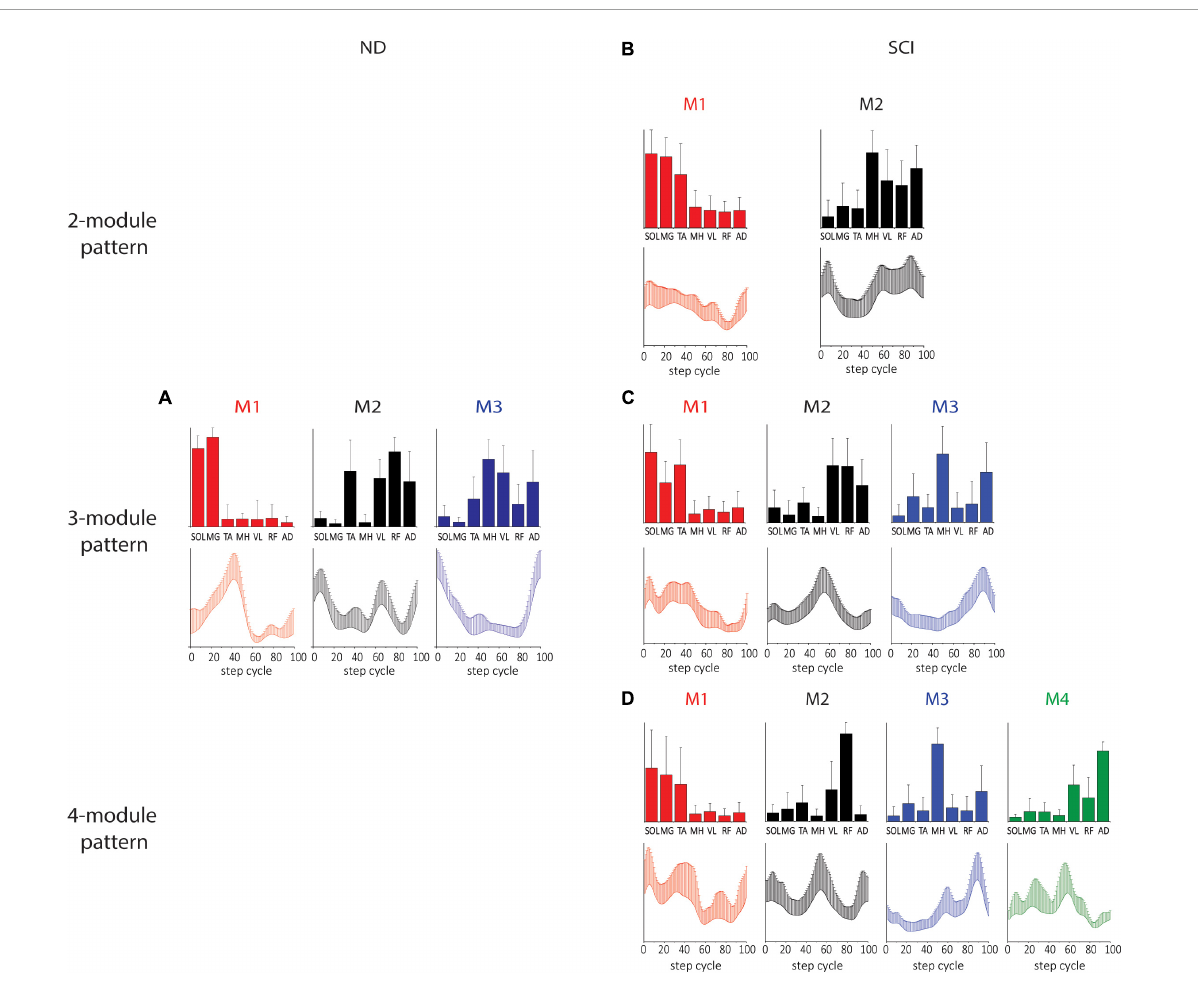
FIGURE2 Spatial and temporal pattern identified by SF-NMF in NDs and SCIs. (A) ND 3-module pattern. (B–D) SCI 2-, 3-, and 4-module patterns. The correlations between the ND and SCI 3-module patterns were weak to moderate. Pearson r for M1 was 0.60 for the spatial patterns and 0.65 for the temporal patterns. For M2, Pearson r was 0.78 for spatial patterns and 0.03 for temporal patterns. For M3, Pearson r was 0.61 and 0.35 for spatial and temporal patterns, respectively. Bar graphs for spatial patterns indicate the group mean + SD. Temporal patterns are also indicated by group mean + SD. SOL, soleus; MG, medial gastrocnemius; TA, tibialis anterior; MH, medial hamstring; VL, vastus lateralis; RF, rectus femoris; AD,